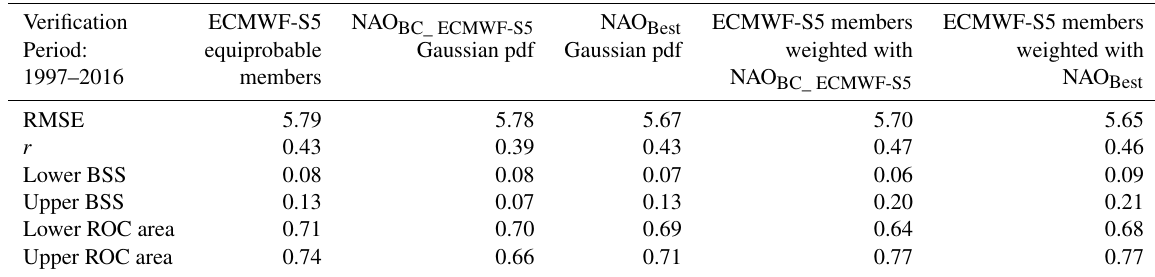
Table 2. Verification scores for the ensemble mean and the pdf of winter index NAO [DJF] forecasts by: ECMWF System-5 with equiproba- ble ensemble members, Bias Corrected ECMWF System 5 Gaussian pdf (NAO BC_ECMWF-S5 ), Best NAO Gaussian pdf (NAO Best ), ECMWF System 5 with ensemble members weighted using NAO BC_ ECMWF-S5 , and ECMWF System 5 with ensemble members weighted using NAO Best . ERAI derived NAO indices are used as observations. The list of indicators displayed in the different rows are: Root Mean Square Error (RMSE) of the ensemble mean of NAO index or mean of Gaussian pdf, correlation coefficient ( r ) of the ensemble mean of NAO index or mean of Gaussian pdf against ERAI NAO index, Brier Skill Score for NAO index anomalies below the lower tercile (Lower BSS), Brier Skill Score Brier Skill Score for NAO index anomalies above the upper tercile (Upper BSS), Relative Operating Characteristic area for NAO index anomalies below the lower tercile (Lower ROC area), and Relative Operating Characteristic area for NAO index anomalies above the upper tercile (Upper ROC